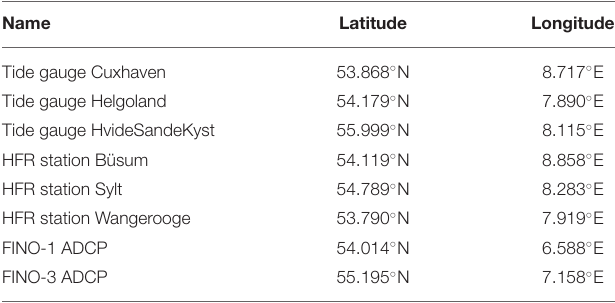
TABLE 1 | Locations of observation instruments used for the model